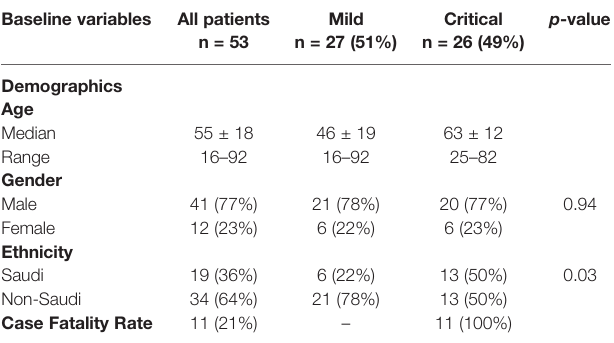
TABLE 1 | Demographics and clinical characteristics of COVID-19 patients. Baseline